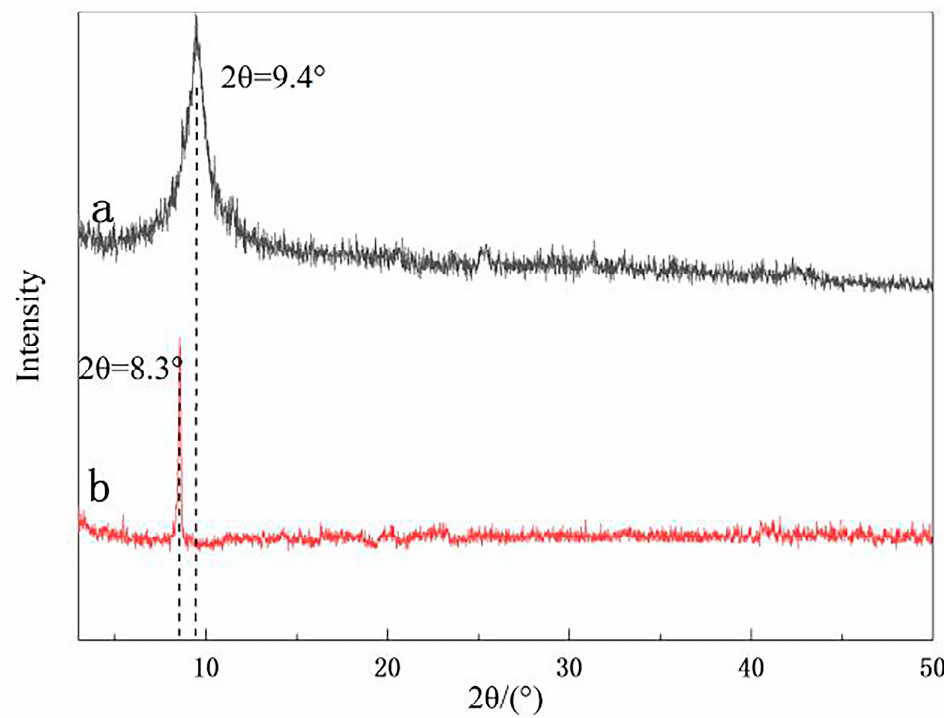
Figure 5. XRD patterns of ( a ) GO, ( b ) STG.